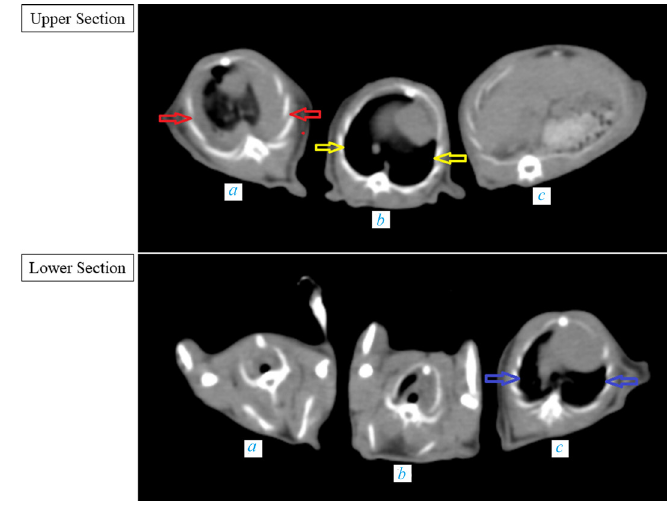
Figure 2. ( a ) Radiological examination with multidetector computed tomography (MDCT) shows bilateral pleural effusion in the lungs of the rats in the cytarabine (CYT) group (upper section). ( b ) In the rutin+cytarabine (R+CYT) group (upper section), the lungs are normal. ( c ) Normal lungs of the healthy control (HG) group (lower